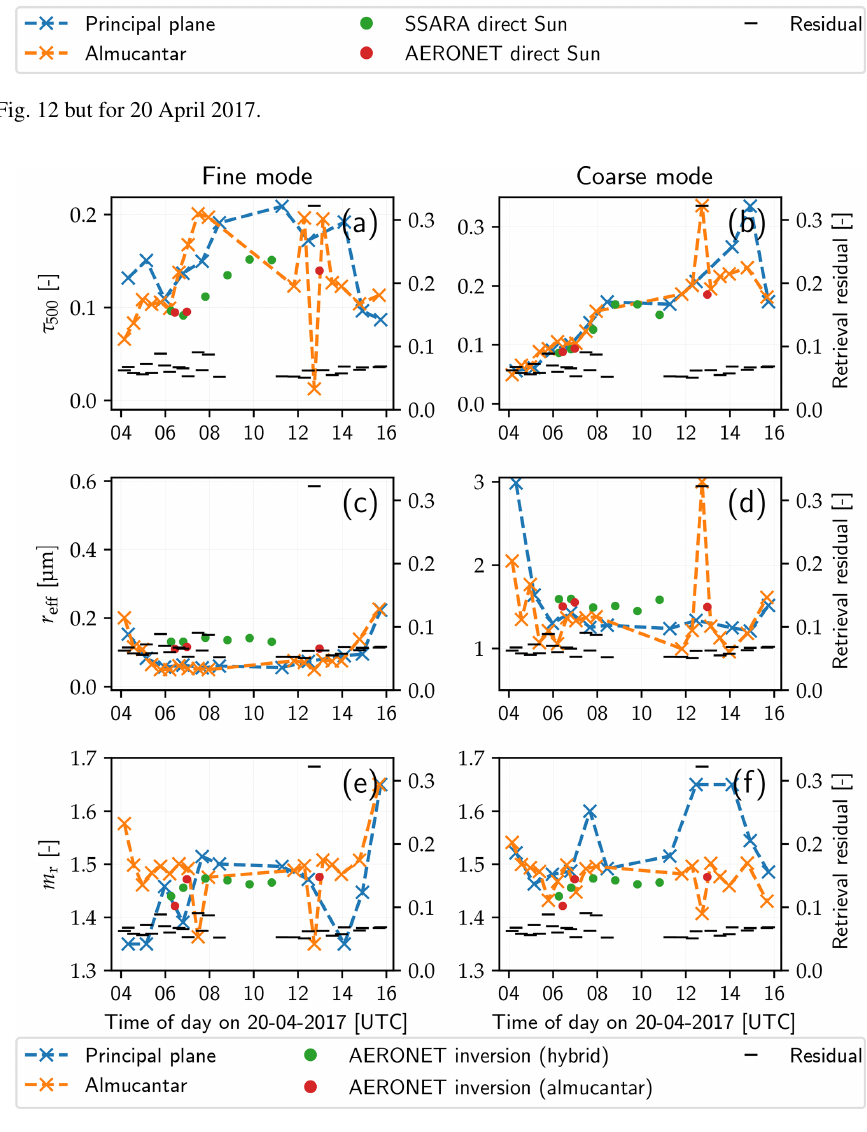
Figure 16. Same as Fig. 13 but for 20 April